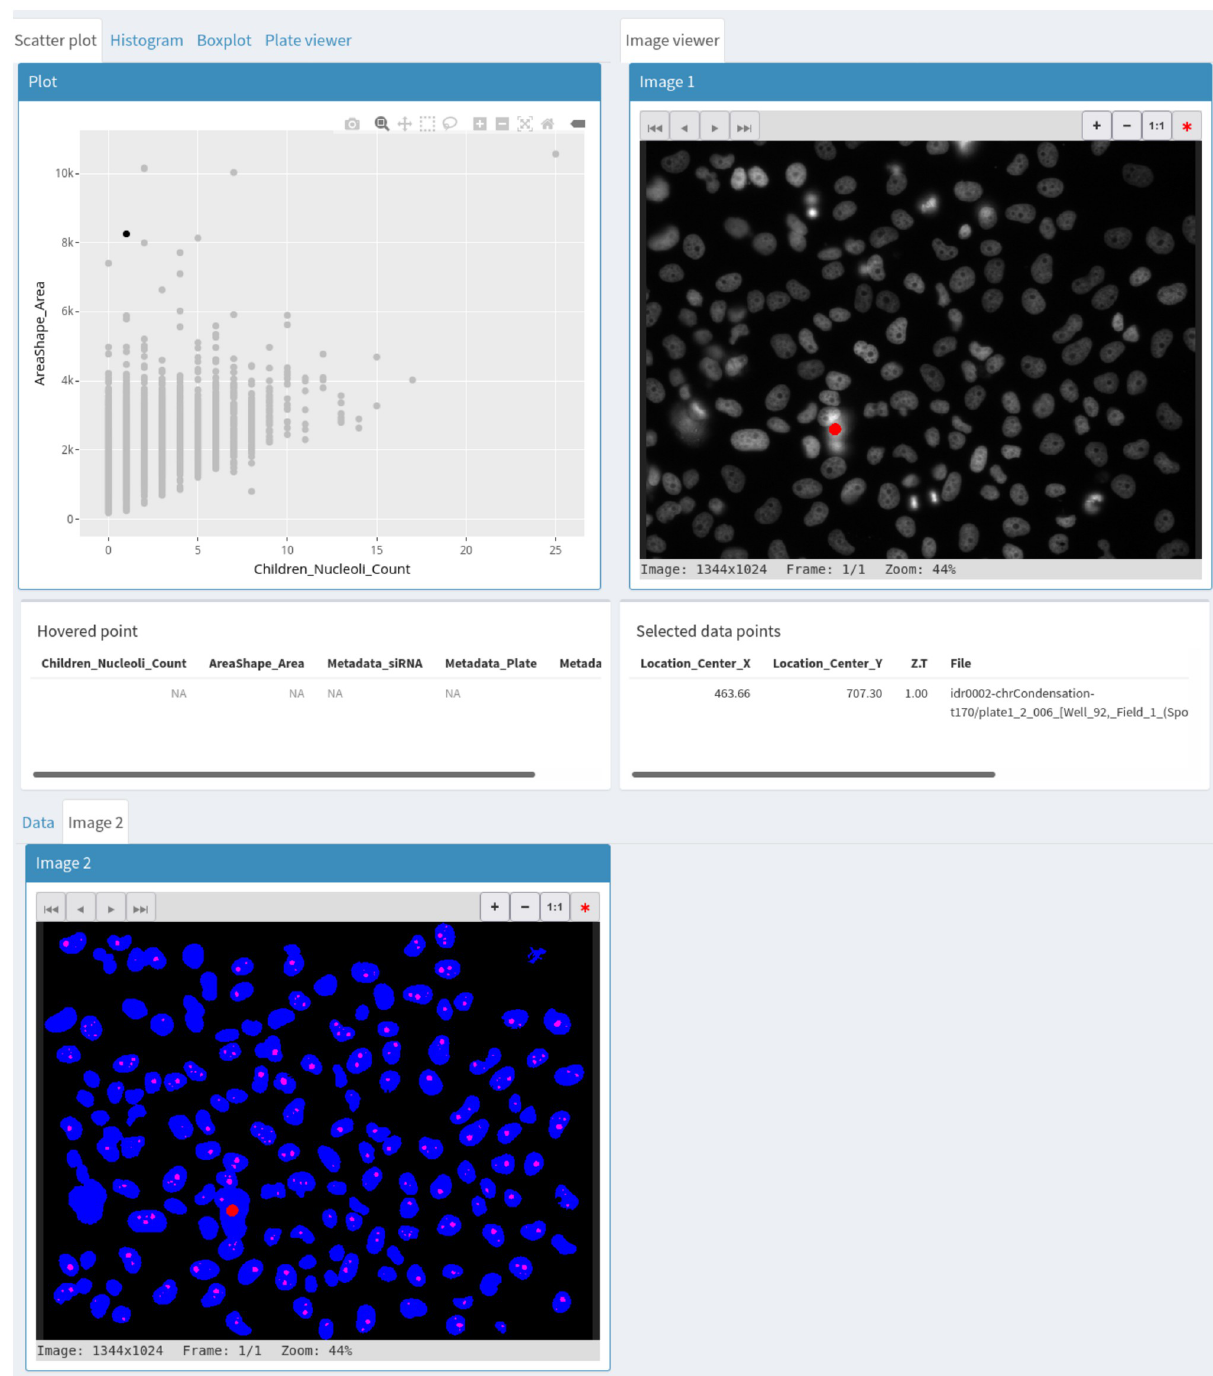
Fig 2. Use of a second image viewer to simultaneously visualize the original image and the segmentation mask corresponding to a selected data point.